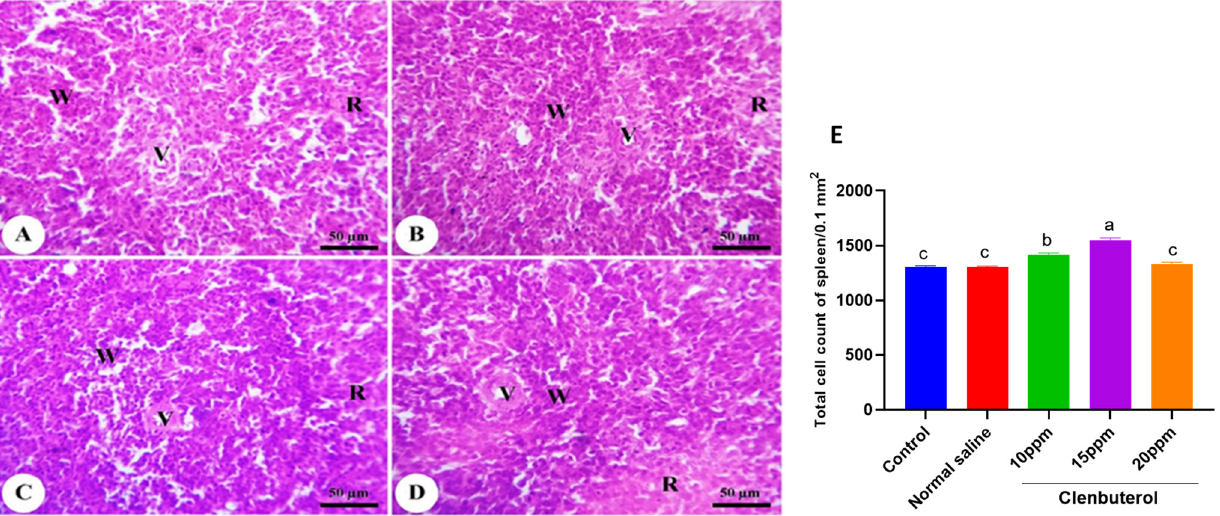
Figure 4. Photomicrograph of spleen of control ( A ) and clenbuterol treated groups of chickens; ( B ) clenbuterol 10 ppm, ( C ) clenbuterol 15 ppm and ( D ) clenbuterol 20 ppm showing white pulp (W) surrounding an artery (V) and loosely arranged blood sinusoids forming the red pulp (R). Stain H&E, scale bar = 50 µ m. ( E ) morphometric analysis of total cell count of splenic parenchyma. Columns with differ superscripts (a, b, c, d) differ significantly ( p < 0.05)